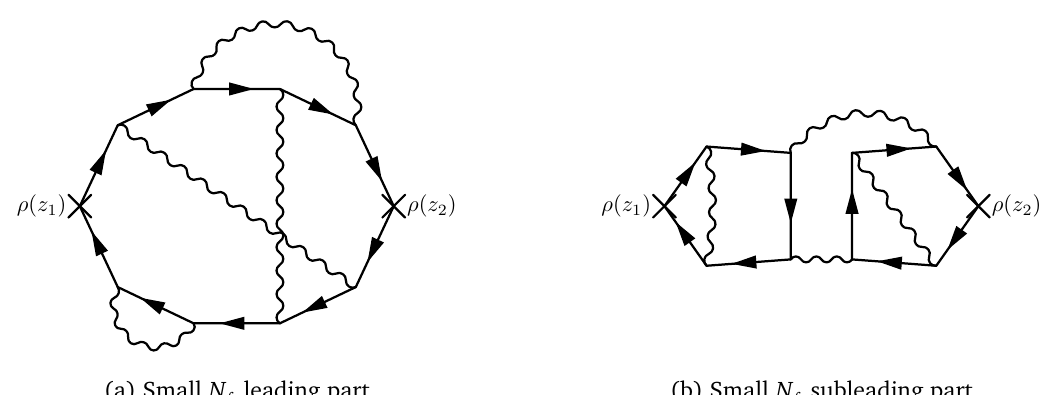
Figure 2: Once the fermionic fields have been integrated out and the resulting determinant set to 1 (by the small N limit) there are two classes of diagrams contributing to the fermion f density-density correlator. (a) Shows one of the diagrams in the first class that contributes at order N (b) Shows a diagram in the second class that contributes at order N 2 f